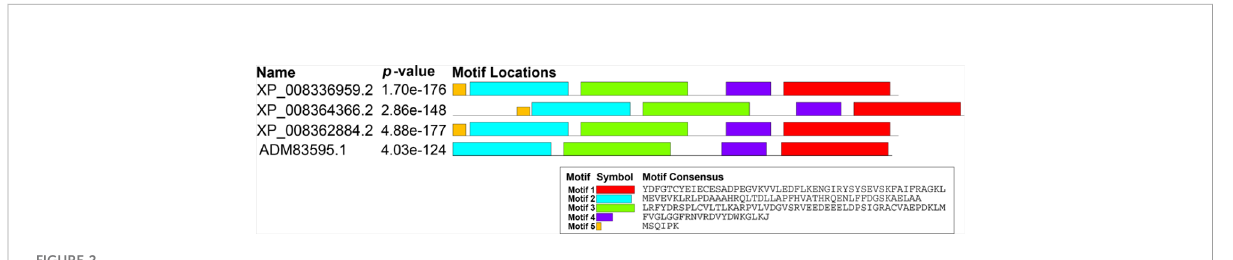
FIGURE 2 Motifs and conserved domains of MdTTM1, MdTTM2, MdTTM3, and HpAC1. MEME suite was used to identify conserved motifs (https://meme- suite.org/meme/tools/meme).